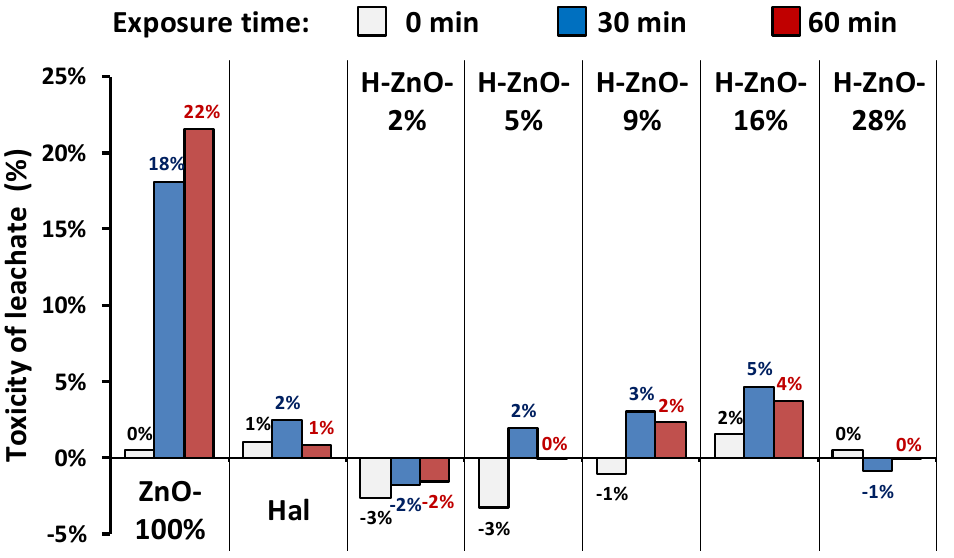
Figure 6. Estimated toxicity of samples leached at pH = 5.6 for 1 h by bioluminescence suppression of Vibrio fischeri strain. Toxicity measurements were carried out after 0, 30, and 60 min of exposure to Vibrio fischeri . Estimated error of measurement was ± 5%.